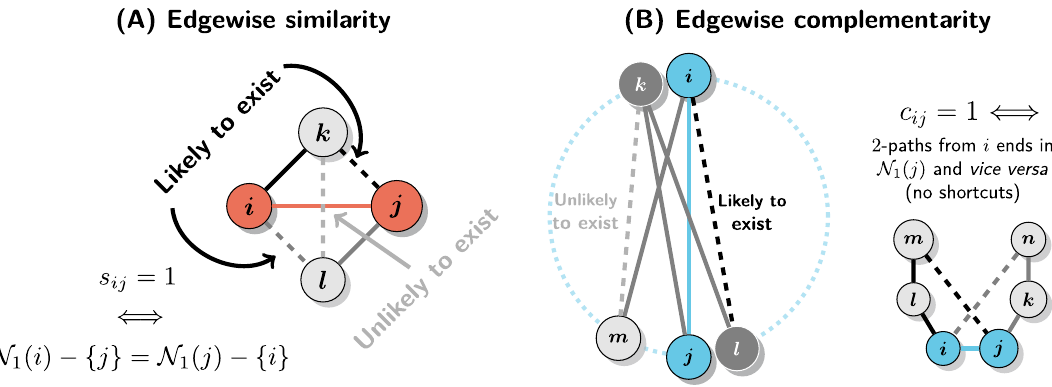
Figure 4. Interpretation of the edgewise structural coefficients. Focal edges are marked with colors (red or blue) and paths starting from the focal ( i , j ) edge are black and dark grey. Solid lines denote paths (triples or quadruples) and dashed lines correspond to closing edges that form triangles or quadrangles. ( A ) Logic of edgewise similarity and the necessary and sufficient conditions for maximum s ij . If ( i , j ) edge is driven